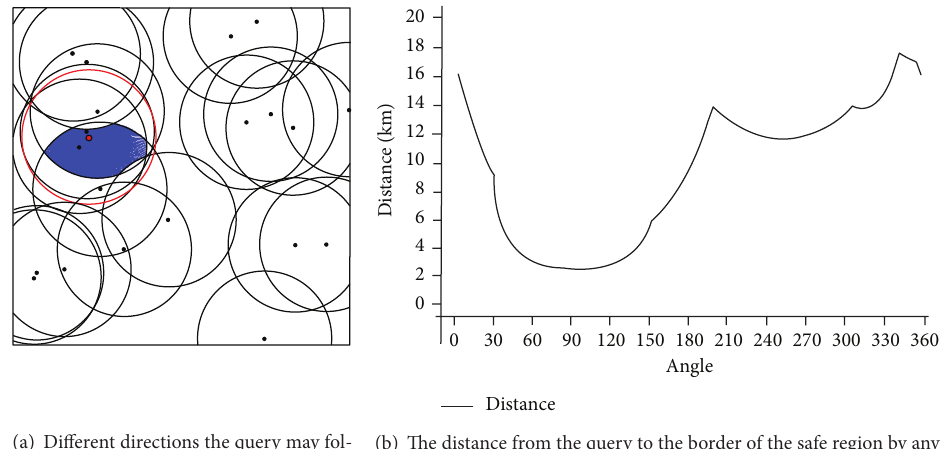
Figure 11: Distance that query can travel before the objects of interest change.